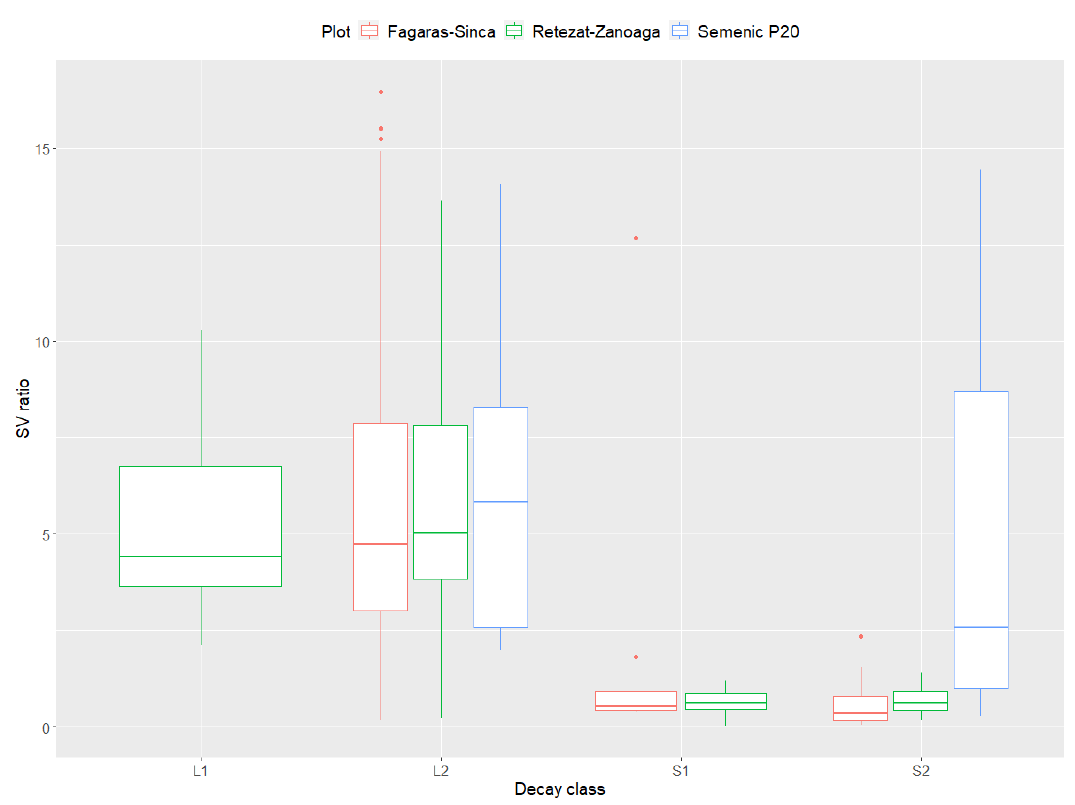
Figure 6. Relation between surface-to-volume ratio and decay class of